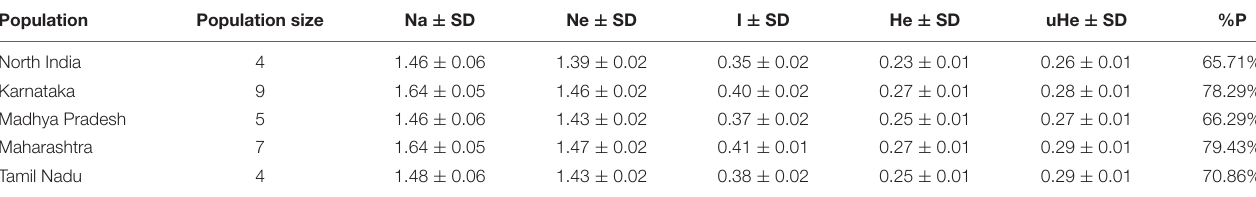
TABLE 3 | Values of different genetic diversity parameters (number of observed and effective alleles, Shannon information index, expected and unbiased expected heterozygosity, and percentage of polymorphic loci) of Puccinia graminis f. sp. tritici groups belonging to five different geographic regions. Population Population size